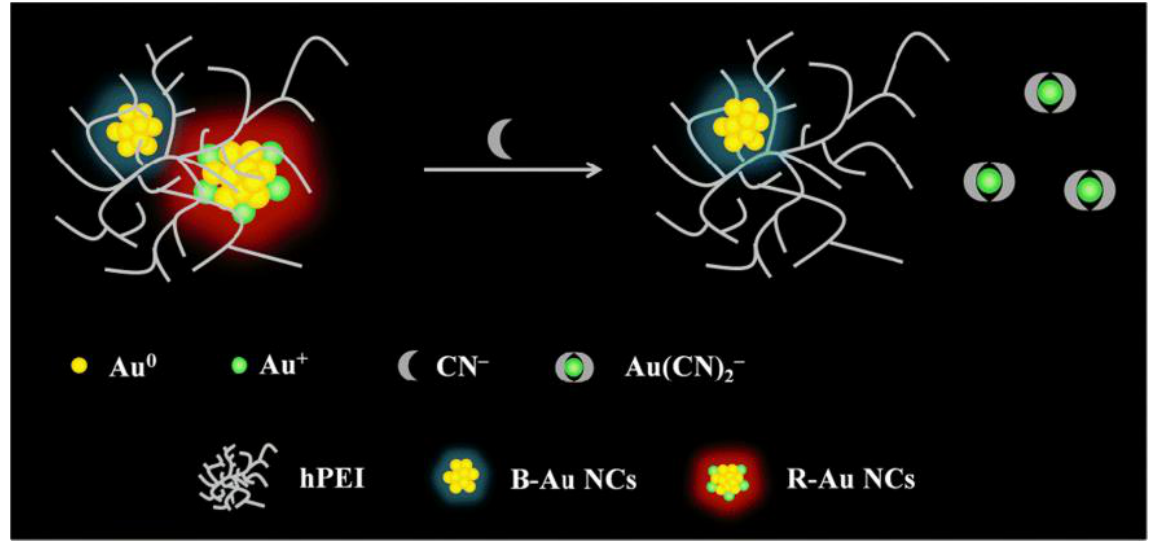
Figure 6. Schematic diagram of constructing ratiometric CN − sensing with CN − etching DE-AuNCs. Reprinted with permission from Ref. [40]. Copyright © 2020, Springer-Verlag GmbH Germany, part of Springer Nature.